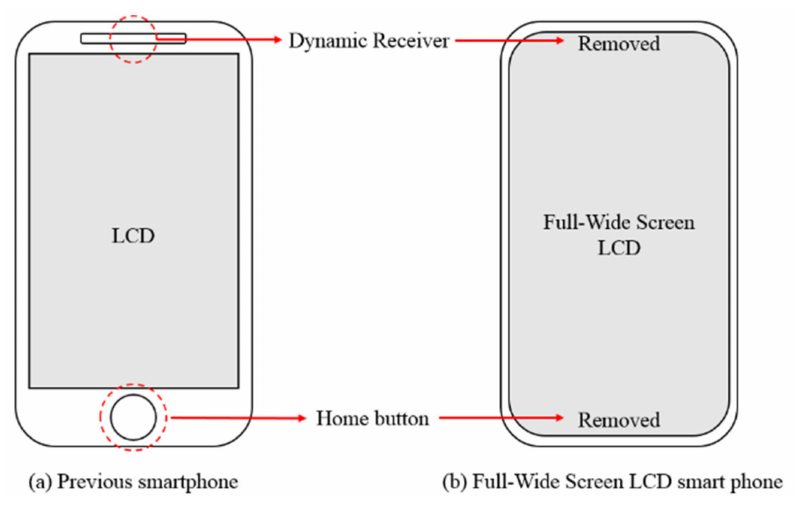
Figure 1. Change of smartphone design.